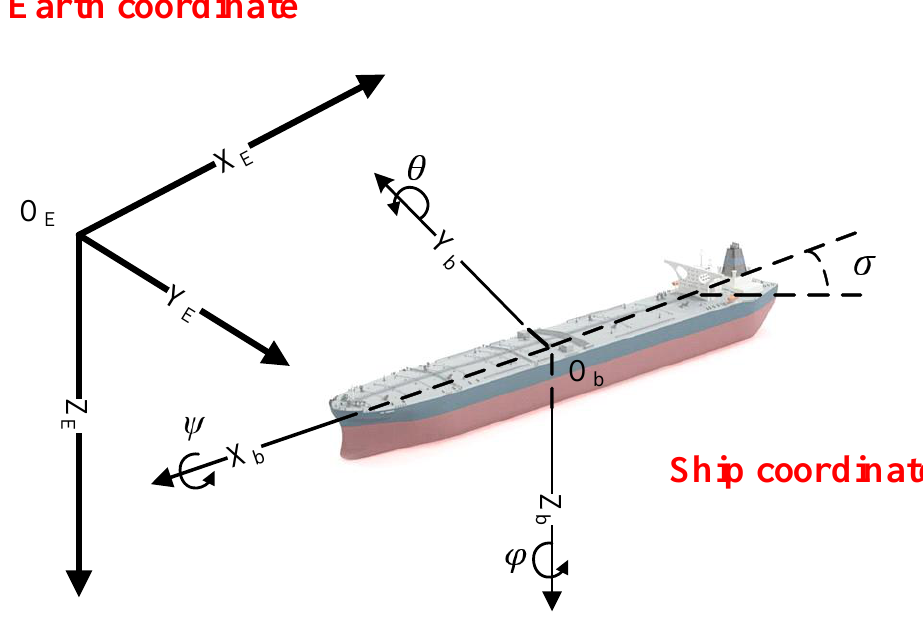
Figure 1. Ship ’ s 6-DOF motion model. Figure 1. Ship’s 6-DOF motion